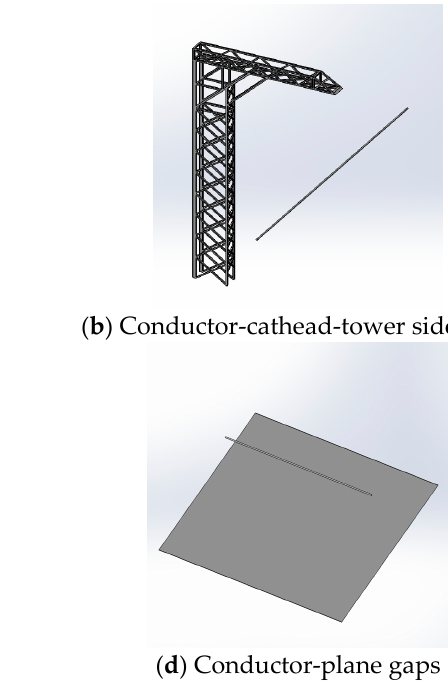
Figure 7. Different conductor gaps.